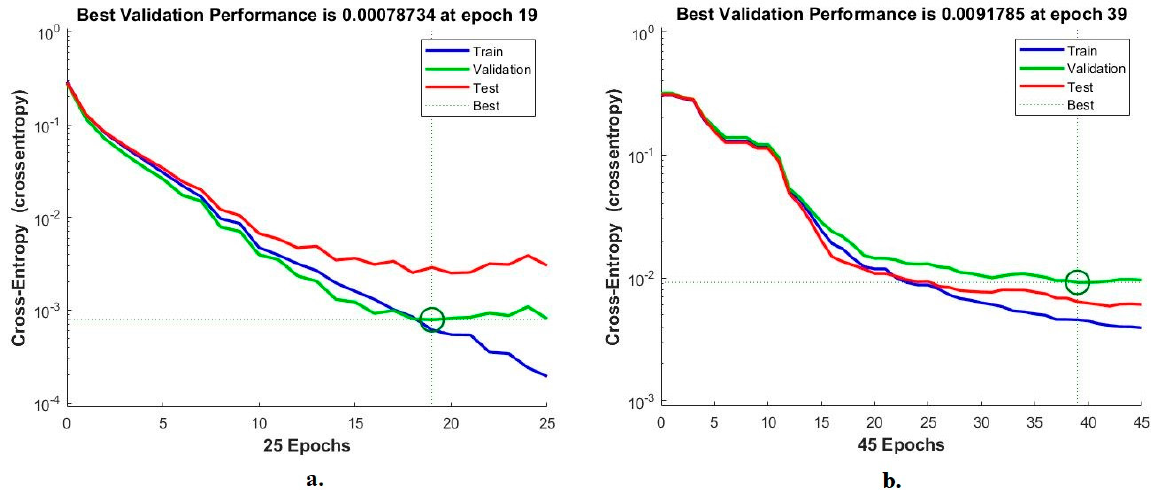
Figure 12. The best validation performance for diagnosing X-ray images of pneumonia and tuberculosis using the ANN with features ( a ). VGG16 and LDG; ( b ). ResNet18 and LDG.